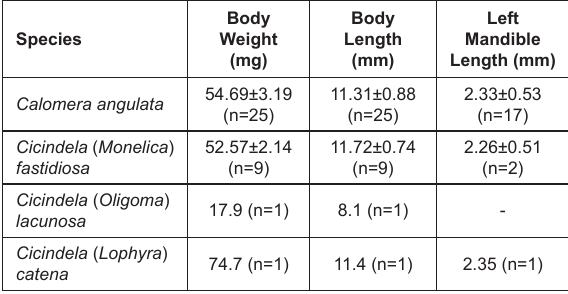
Table 4. Morphometric characters recorded for the tiger beetle species of reservoir ecosystems of Sri